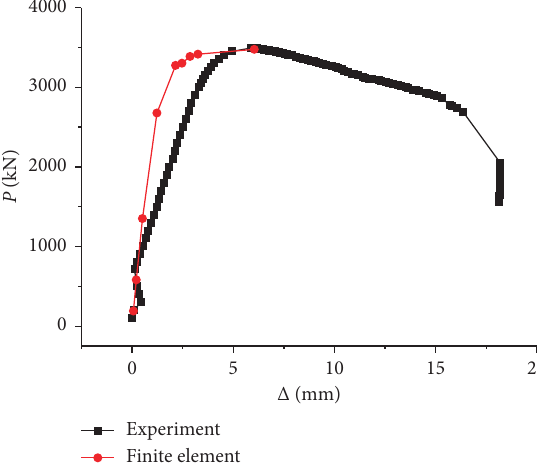
Figure 10: Comparison of load-displacement